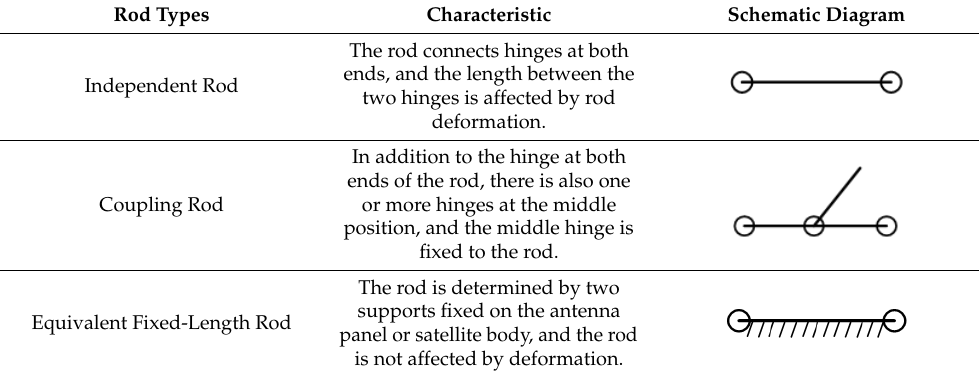
Table 1. Rod types of the LSDM. Characteristic Schematic